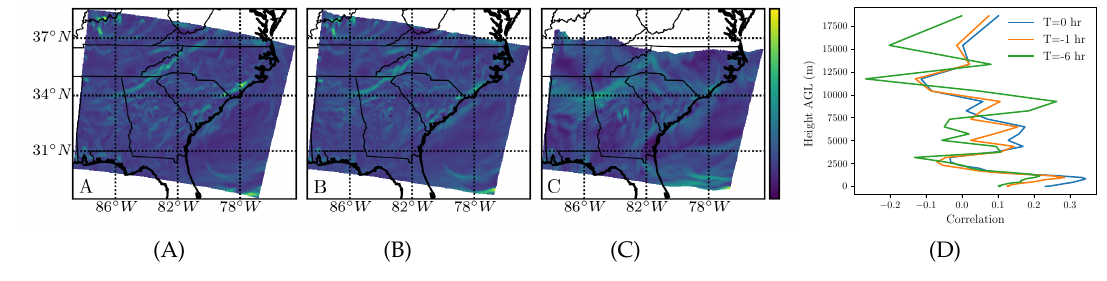
Figure 7. The same as in Figure 4, but for sulfate (SO 2-